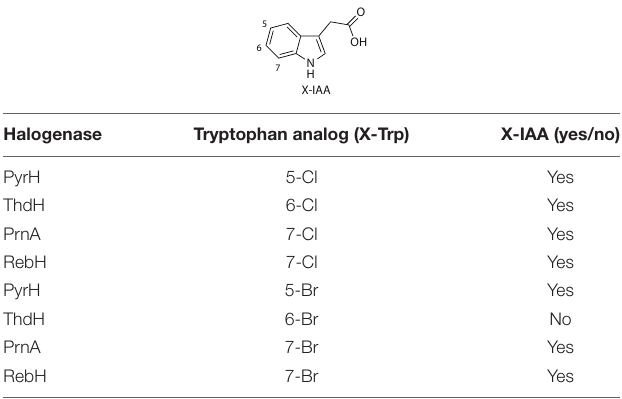
TABLE 1 | Halo-IAA production results following halogenase infiltration. TABLE 2 | Results from Trp-analog infiltration